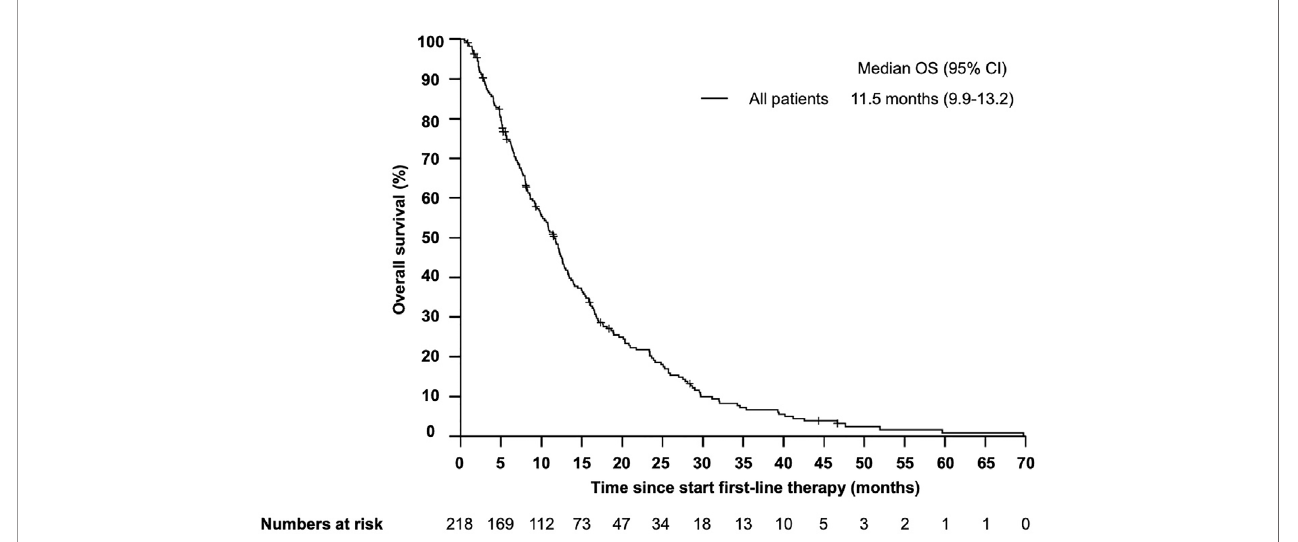
FIGURE 1 | Kaplan – Meier plot for overall survival (OS) in patients with r/m SCCHN from start of fi rst-line therapy. The median overall survival was 11.5 months (95% CI 9.9 – 13.2